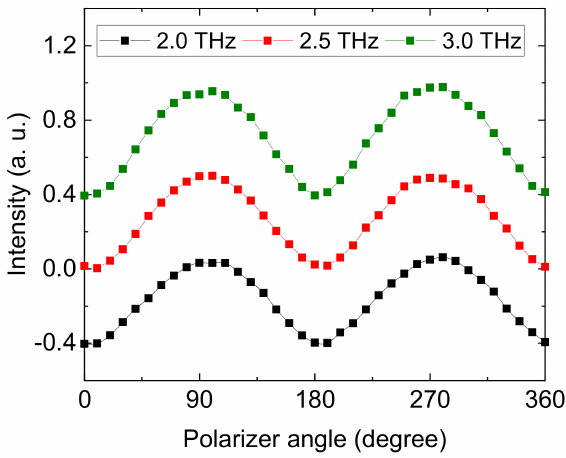
Figure 3. Terahertz polarization properties at each frequency, obtained using 2.0 THz, 2.5 THz, and 3.0 THz bandpass filters (FB19M150, FB19M120 and FB19M100, respectively, Thorlabs, Inc., Newton, MA, USA).